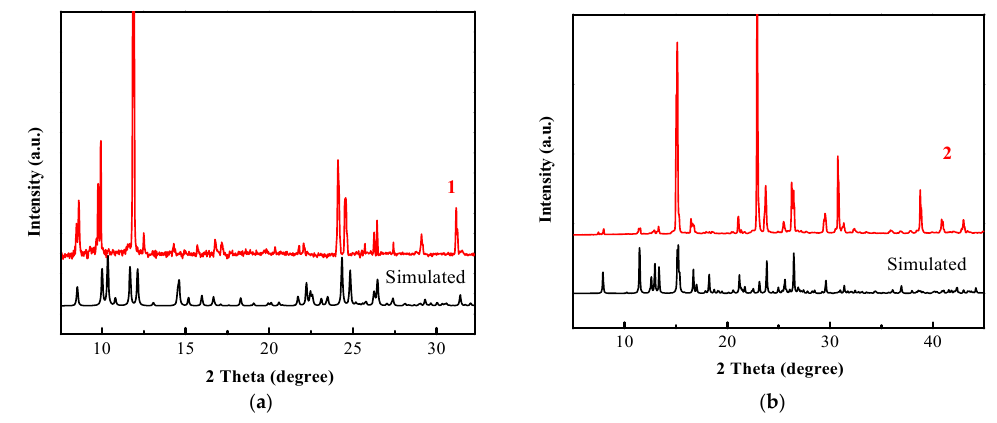
Figure 5. The experimental and simulated PXRD patterns for 1 ( a ) and 2 ( b ).